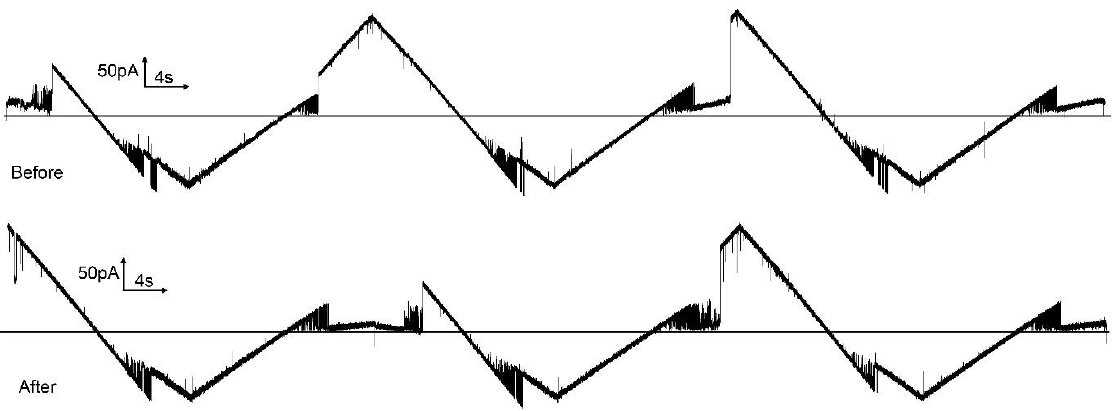
Figure 9. Trypsin failed to cleave the sensors of any subunits when added to the cis side when subunits 2 and 3 were in the open state. The upper trace was recorded before trypsin addition (triangular wave +80/ − 80 mV; 30 mHz). A constant 10 mV was applied followed by trypsin addition (40 µ g to the cis compartment). After 10 min of trypsin treatment, 1 mg of soybean trypsin inhibitor was added to the cis compartment and the triangular voltage wave was resumed (lower trace). Subsequent addition of 40 µ g trypsin to the trans compartment resulted in rapid reopening of subunit 2 and loss of voltage gating (not shown).